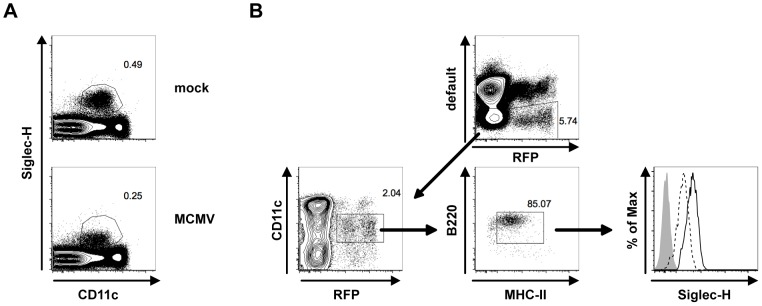
Siglec-H is downregulated upon MCMV infection in vivo.pDCre x RFP mice were infected with 5×104 PFU MCMV in vivo. (A) Representative FACS plots show CD11c versus Siglec-H of live splenocytes at 36 h p.i. (B) Gating strategy showing exclusion of B-, T-, NK-T, and NK cells by CD19, CD3ε, NK1.1 in a default channel. RFP+ pDCs were gated as CD11cint B220+ MHCIIint to exclude MHCII− DC precursors. Histogram overlays show RFP+ pDCs from mock (bold line) and MCMV infected (dashed line) pDCre x RFP mice at 36 h p.i. Isotype staining is displayed as grey histogram. Data are representative of 2 independent experiments using 4–5 mice with comparable results.